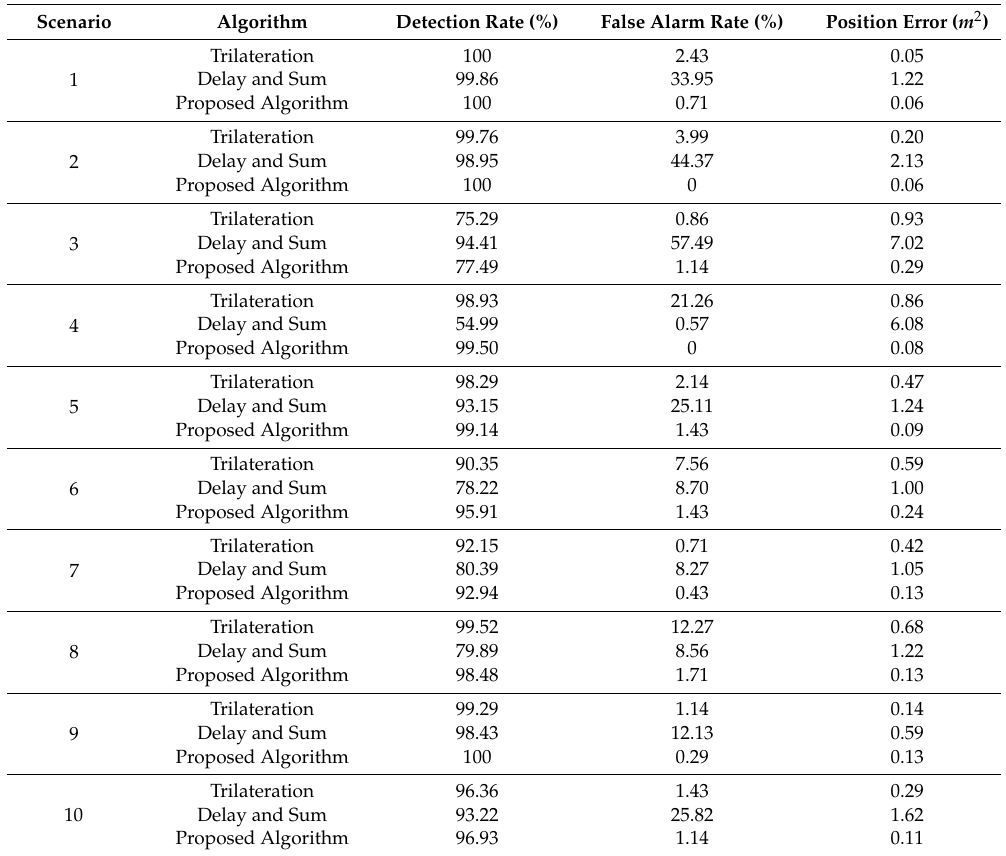
Table 4. Experimental Results for the